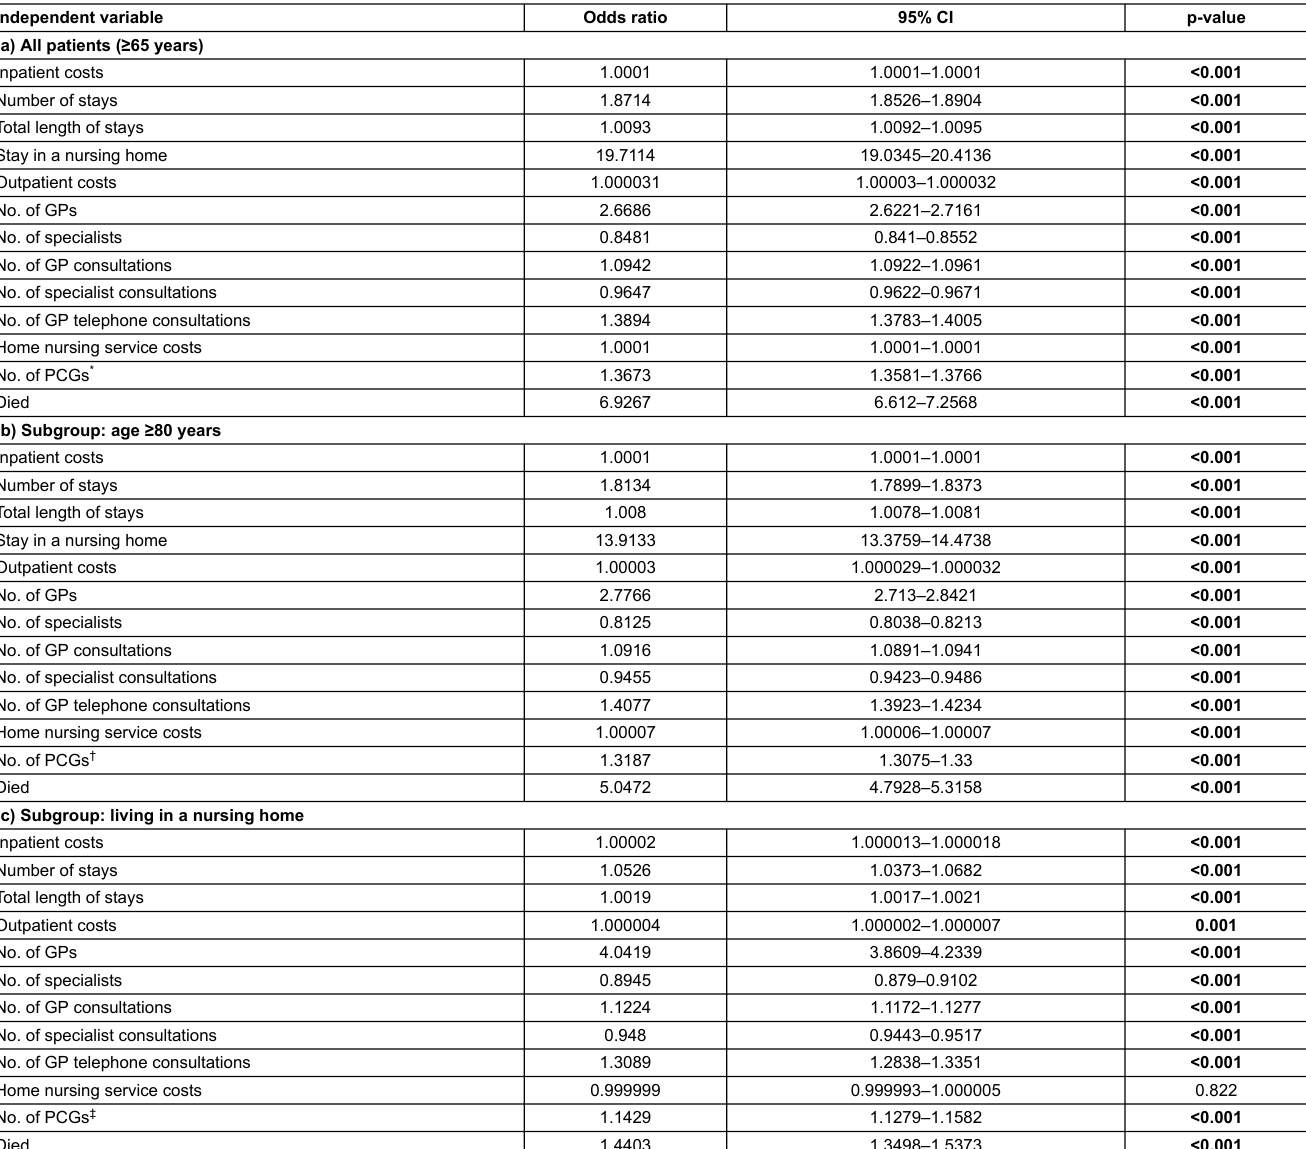
Table 3: Multiple logistic regression analyses testing the effects of patient characteristics regarding health conditions and healthcare utilisation on the likelihood of receiving at least one GP home visit for 2018 for (a) overall patients in the Swiss population (extrapolated) (aged ≥65 years); (b) subgroup of patients ≥80 years; (c) subgroup of patients liv- ing in a nursing home in the same year,